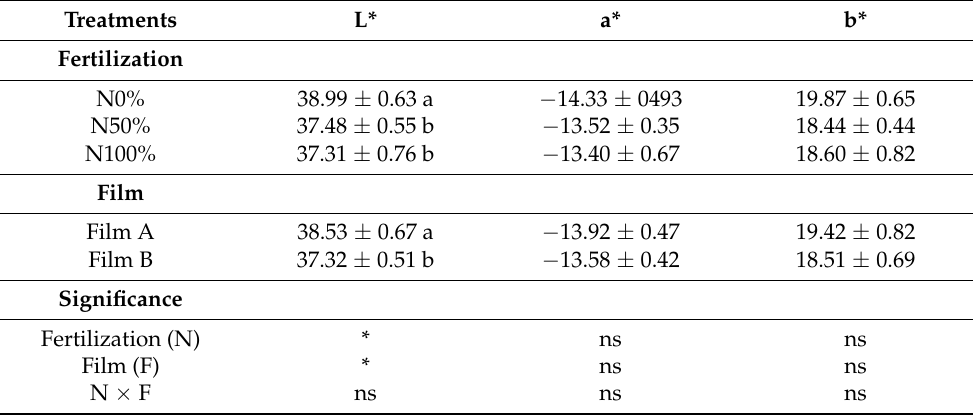
coordinate) of spinach